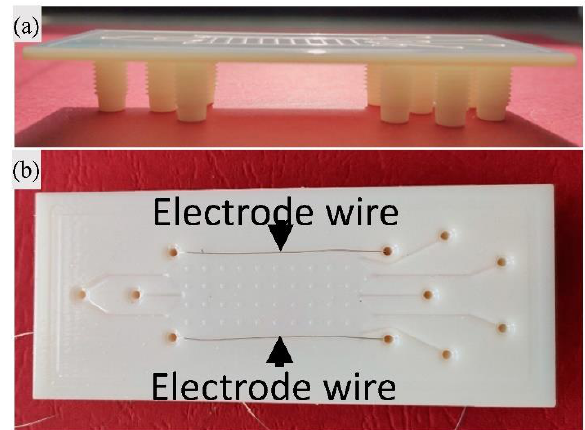
Figure 8. Images of µ FFE device produced by Barbaresco et al. [109]: ( a ) image of 3D-printed device; and ( b ) image of 3D-printed µ FFE device after the electrode insertion.